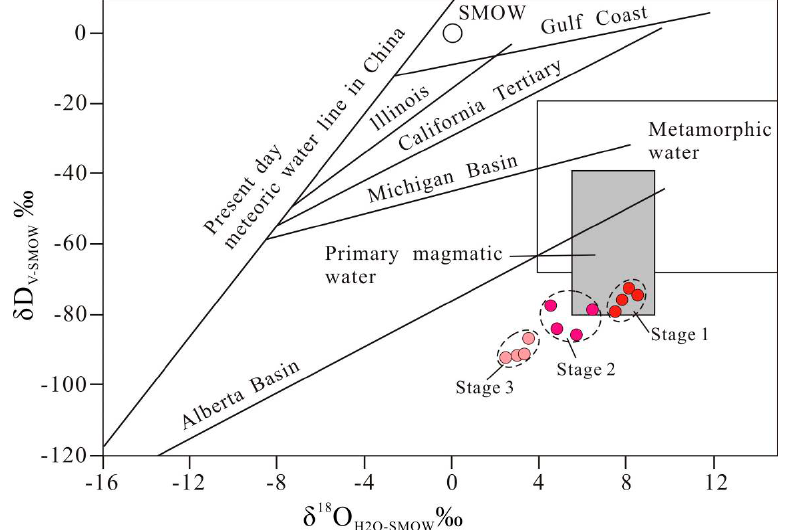
Figure 10. δ D versus δ 18 O diagram for quartz from different stages of mineralization in the Jinchang deposit. Trend lines shown for reference are data from the Gulf Coast, Illinois, and Michigan basins [49], Alberta Basin [50], and Californian Tertiary geothermal brines [51]. The fields for metamorphic and primary magmatic waters are from Taylor [52]. Data used to derive a present-day meteoric water line for China are from Chen and Wang [53].